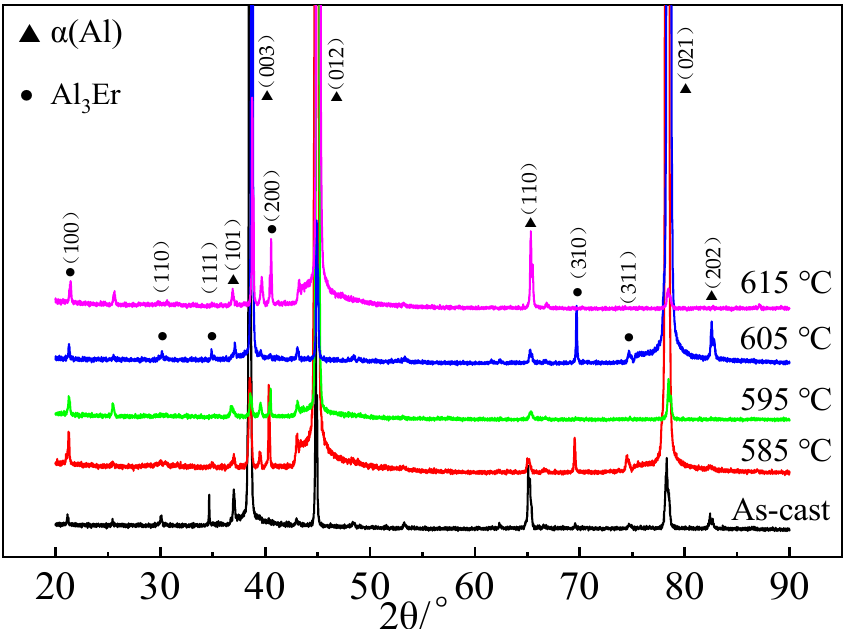
Figure 7. XRD patterns of Al-5Zn-0.03In-1Er alloy after treatment at different temperatures for 24 h. After studying the effect of temperature on the microstructure of the alloy, it was found that 615 ◦ C was worth studying; therefore, a series of studies were carried out to explore the effect of UHTT on the alloy microstructure at different times at 615 ◦ C.